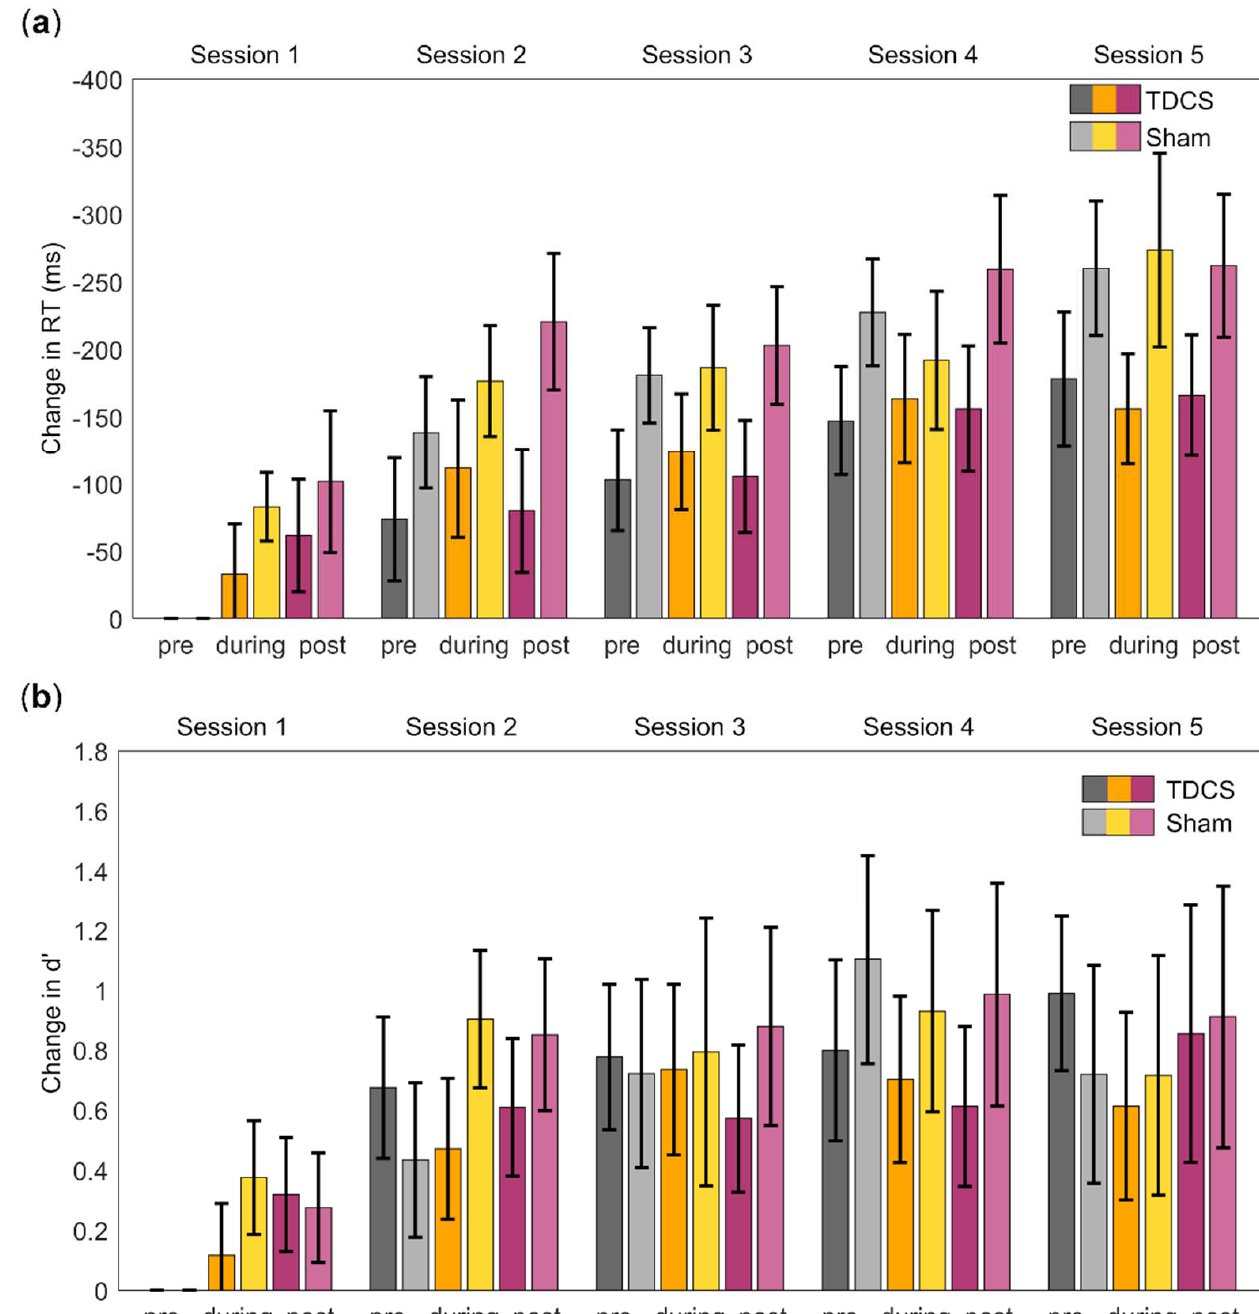
Figure 2. Performance during the 2-back task, measured by reaction times (RTs) and d-prime (d’), before, during, and after stimulation over the five sessions. ( a ) Change in RTs in ms for the response type Hit relative to Session 1 pre-stimulation. ( b ) Change in d’ relative to Session 1 pre-stimulation. Error bars = standard error of the mean. Both measures indicated improved performance over time but no significant difference between the groups.